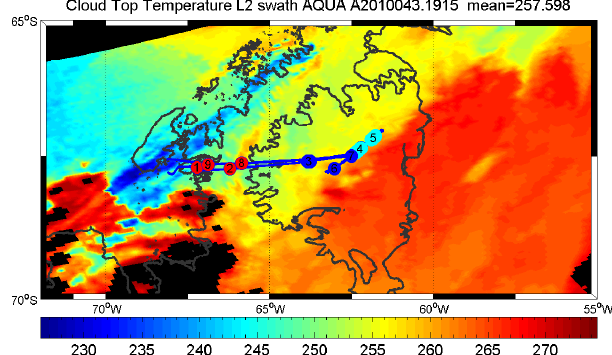
Fig. 3. MODIS satellite cloud top temperature (K) from 19:15UTC on the day of flight 104 with the flight track and markers as for Fig. 2 except that the Hallett Mossop markers (4 and 5) are now a different colour for clarity.